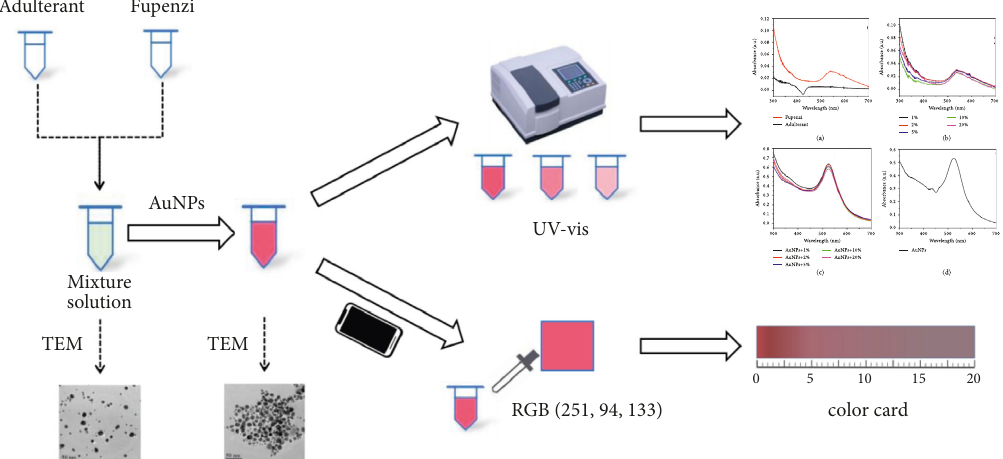
Figure 1: The flowchart of adulteration detection of Fupenzi.